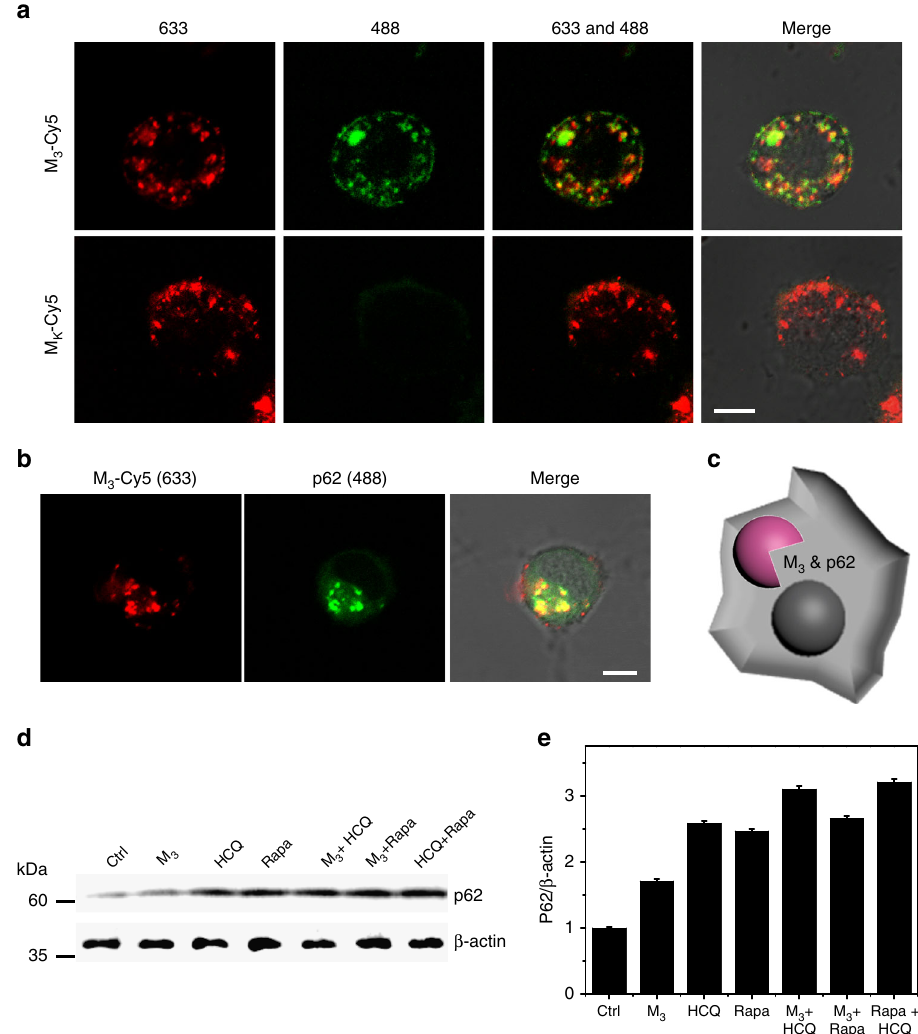
Fig. 6 M 3 induced autophagic degradation in vitro. a CLSM images showed the co-localization of the autophagosome (GFP-LC3-positive puncta, green signals) and M 3 -Cy5 (red signals). N2a/GFP-LC3 cells were treated with M 3 -Cy5 (200 μ g/mL) and M K -Cy5 as a control for 24 h. b CLSM images showed the co-localization of M 3 -Cy5 (red signals) and p62 (green signals from anti-p62-labeled secondary antibody). c The schematic illustration of M 3 degradation by autophagy. d Western blot of p62 and ( e ) the corresponding quanti fi ed results. N2a cells were cultured as follows: in regular culture medium for 24 h (lane 1); M 3 (200 μ g/mL) for 24 h (lane 2); 5 μ M HCQ for 1 h (lane 3); 1 μ M Rapa for 1 h (lane 4); with M 3 (200 μ g/mL) and HCQ (lane 5); with M 3 (200 μ g/mL) and Rapa (lane 6); with Rapa and HCQ (lane 7). Data are presented as mean ± s.d. ( n = 3). Scale bar in ( a , b ) is 10 µ (Fig. 6e). These fi ndings validated that M 3 activated autophagy without blockade of the autophagic fl ux, indicating the possibility of autophagic degradation of A β 42 .